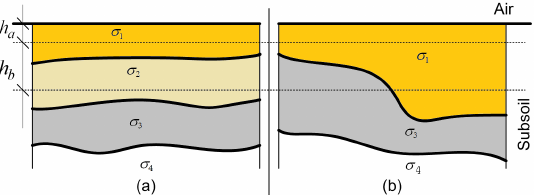
Figure 4. Illustration where there is a need for 3D mapping: ( a ) any traditional mapping and ( b ) using 3D mapping only.